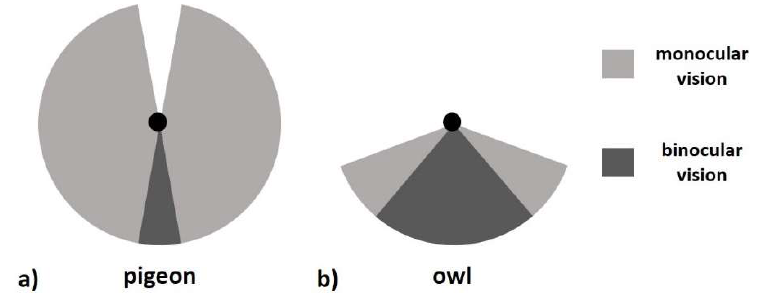
Figure 9. Field of view (in the horizontal plane) of ( a ) a pigeon ( Columba livia ) that scans for predators and ( b ) a tawny owl ( Strix aluco ) looking for prey. Note the differences in total field of view and binocular vision (after [56]).